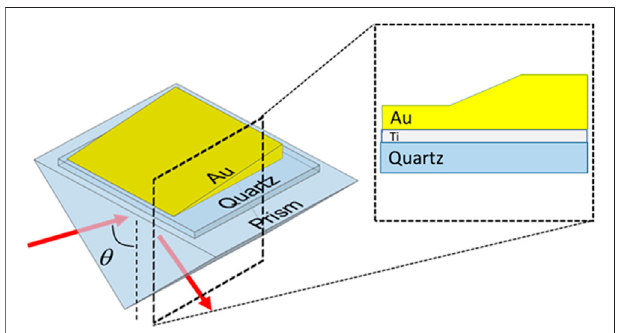
FIGURE 1 | A schematic illustration of a wedge-shaped Au thin fi lm mountedonaquartzglassprismfortheattenuatedtotalre fl ection(ATR)setup used for